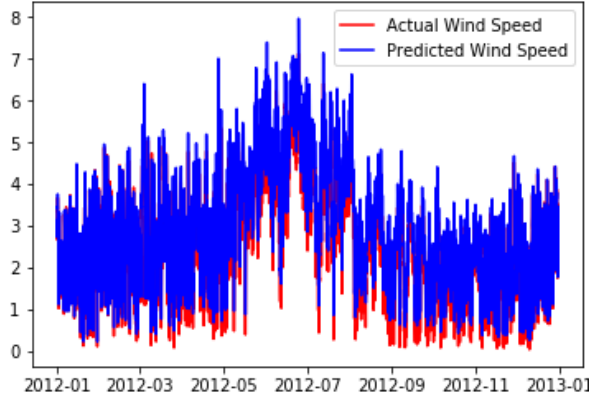
Figure 10. LSTM Wind Forecasting